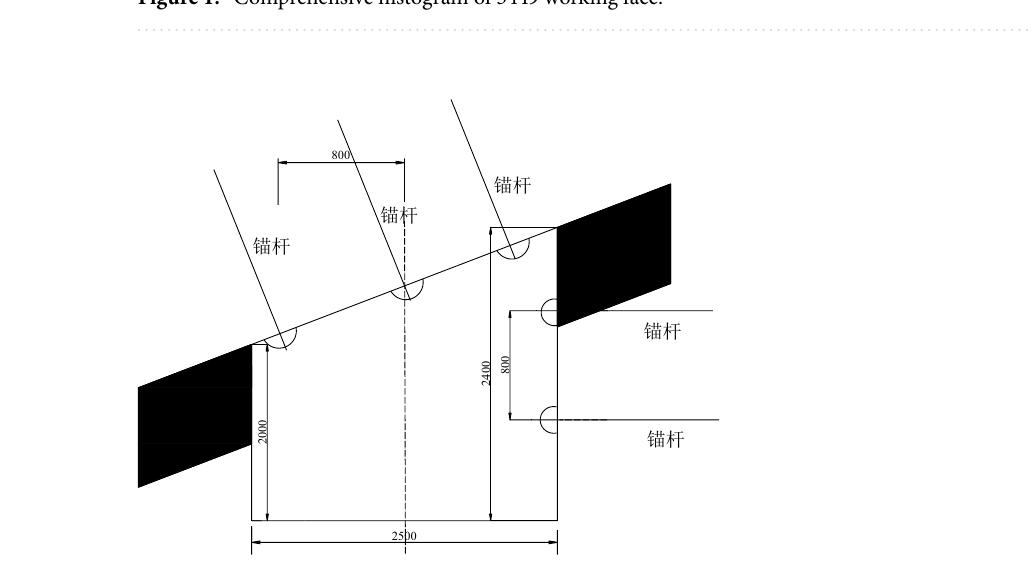
Figure 1. Comprehensive histogram of 5449 working face.